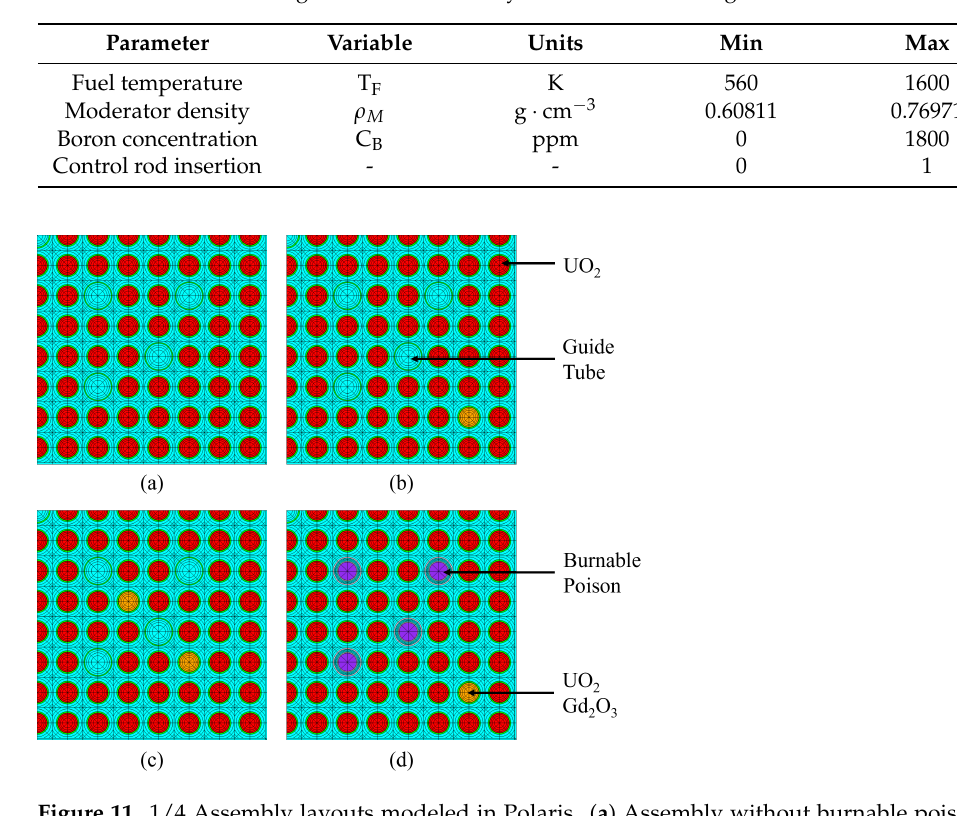
Table 4. Parameter coverage used for the history and branch modeling in the fuel assemblies.